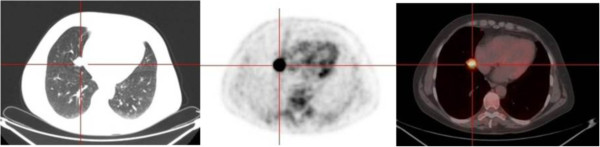
The integrated FDG-PET/CT reveals a small TC (20 mm) demonstrating high uptake (SUVmax 12.9). From left to right: CT, PET and fused image.